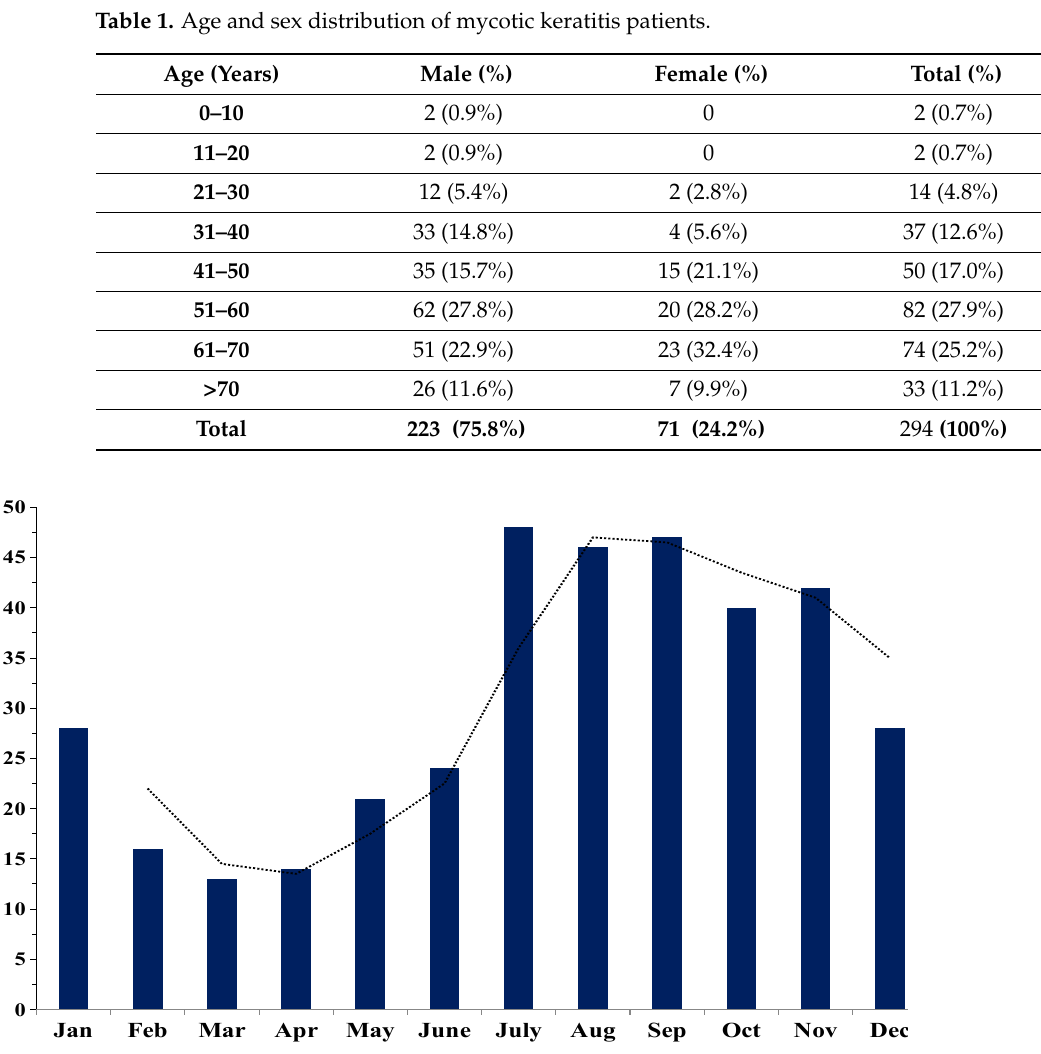
Figure 1. Seasonal trends in the occurrence of fungal keratitis cases between 2012 and 2020. (The dotted line was represented the trend of the prevalence of FK in each